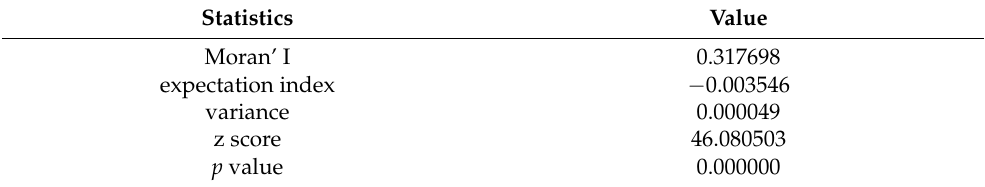
Table A1. Global Moran I